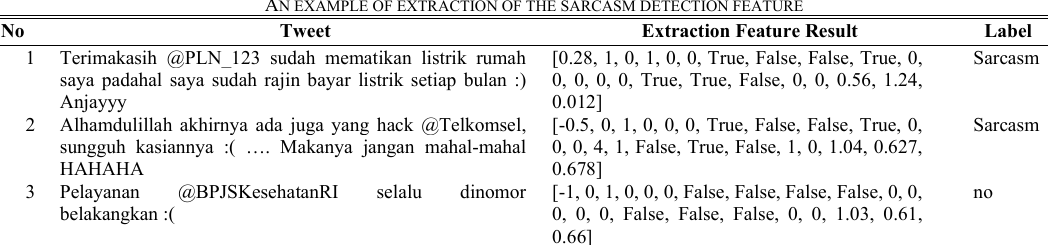
TABLE 2 A N EXAMPLE OF EXTRACTION OF THE SARCASM DETECTION FEATURE